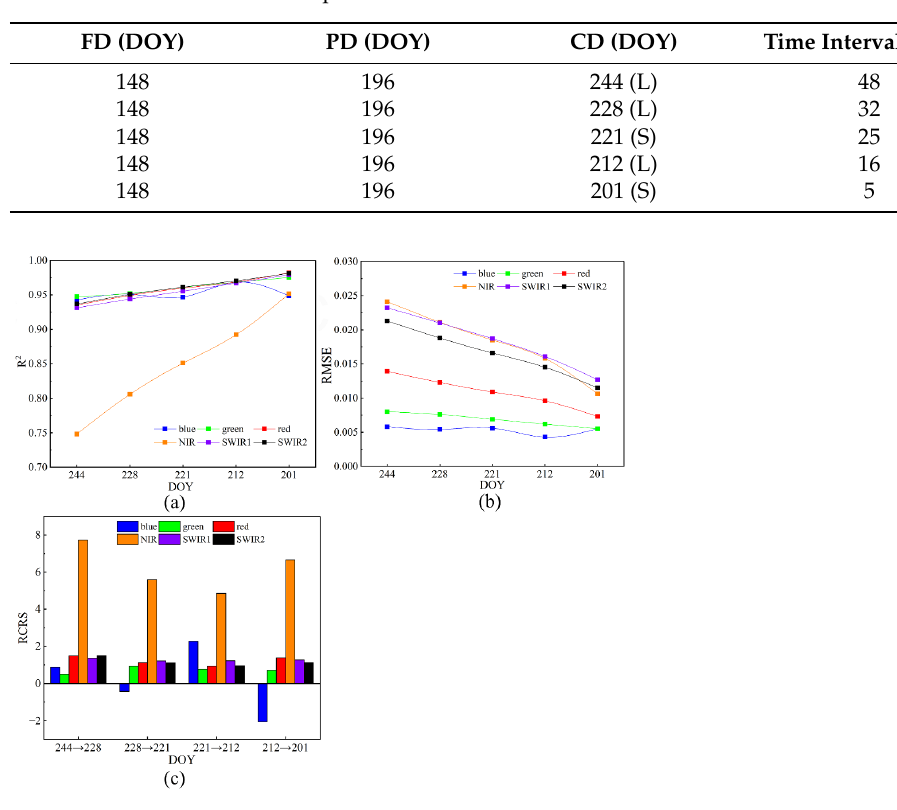
Table 1. Data selected for MLC period.